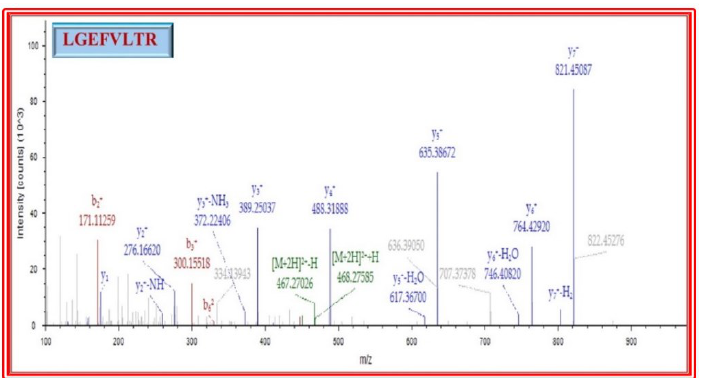
Figure 8. MS-MS spectra of chickpea purified peptide.